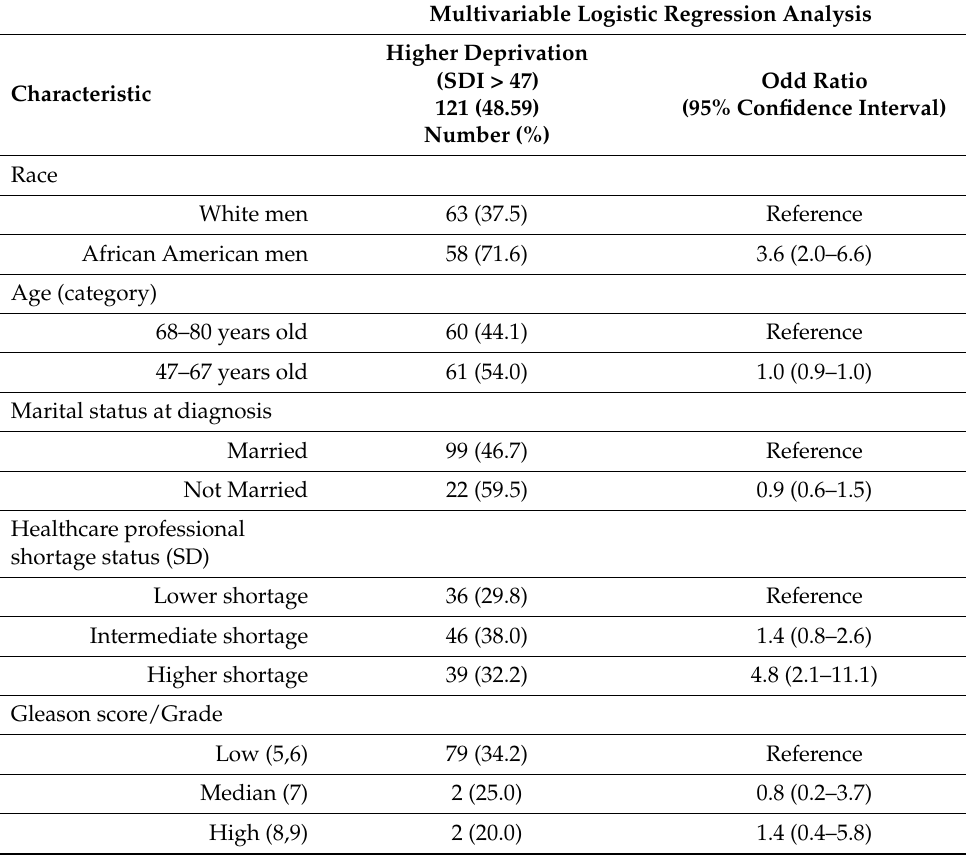
Table 3. Multivariate logistic regression model of social deprivation.